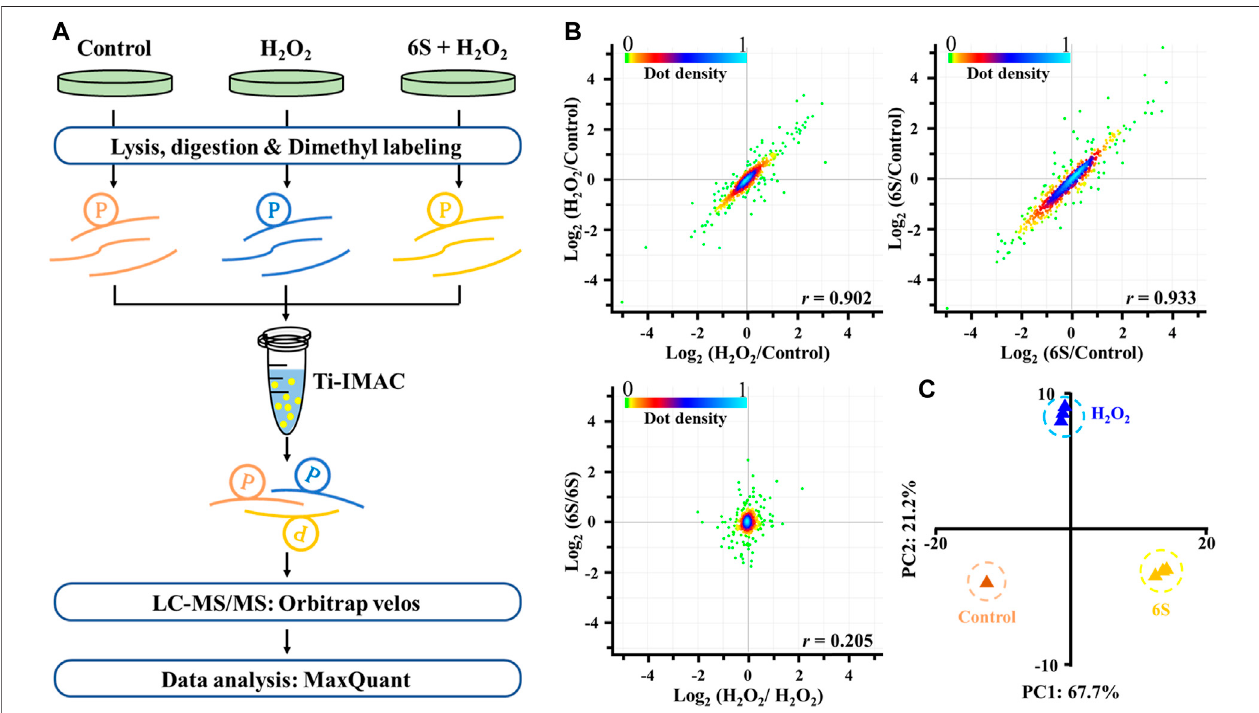
FIGURE 3 | Mass spectrometry-based quantitative phosphoproteomic pro fi ling of H 2 O 2 injury and 6S protection. (A) Work fl ow of the mass spectrometry-based phosphoproteomic analysis.Digestedpeptidesfromthreedifferentexperimental conditionsweredimethyl-labeled, combined,and enriched forphosphopeptidesusing Ti-IMAC microspheres. Finally, the phosphopeptides were analyzed by LC-MS/MS. (B) Representative null comparisons (ratio of two replicates for H 2 O 2 group and 6S group) displayed markedly distinct patterns from true comparisons (ratios of H 2 O 2 /control and 6S/control). (C) Principal-component analysis of all identi fi ed phosphorylation sites showed that samples cluster tightly according to biology. The log2 ratios of phosphorylation sites in the control group defaulted to 0.